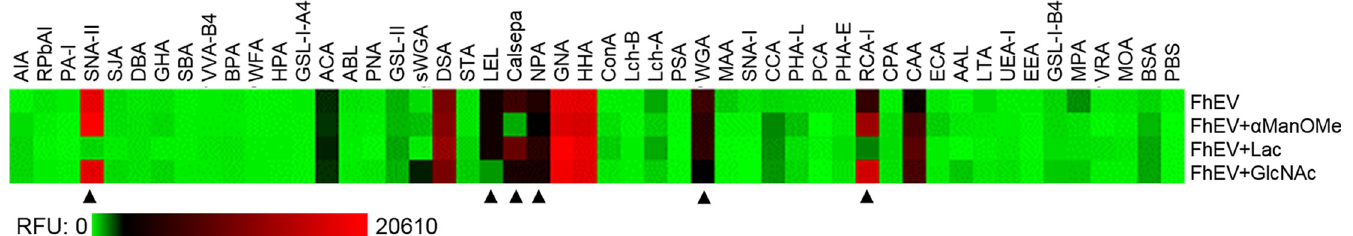
Fig 5. Competitive inhibition of lectin binding on the 120k EV surface.Arrowheads indicate significant ( p � 0.05) mean lectin microarray response changes imparted by competitive inhibition with 50 mM final concentrations of Lac, α ManOMe or GlcNAc as indicated.